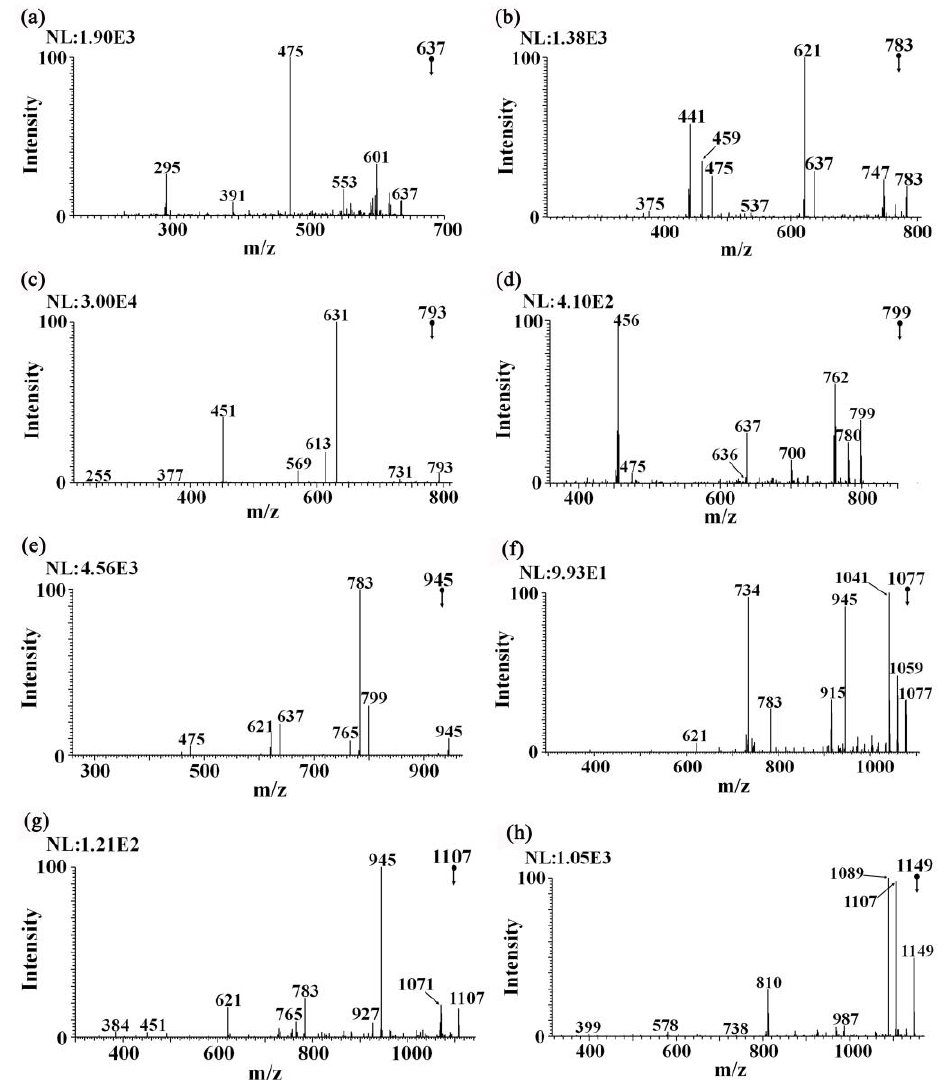
Figure 5. Tandem MS analysis of typical ginsenosides in ginseng under forest and two Panax quinquefolium samples detected with iEESI-MS: ( a ) MS 2 spectrum of m / z 637 → , ( b ) MS 2 spectrum of m / z 783 → , ( c ) MS 2 spectrum of m / z 793 → , ( d ) MS 2 spectrum of m / z 799 → , ( e ) MS 2 spectrum of m / z 945 → , ( f ) MS 2 spectrum of m / z 1077 → , ( g ) MS 2 spectrum of m / z 1107 → , and ( h ) MS 2 spectrum of m / z 1149 → .